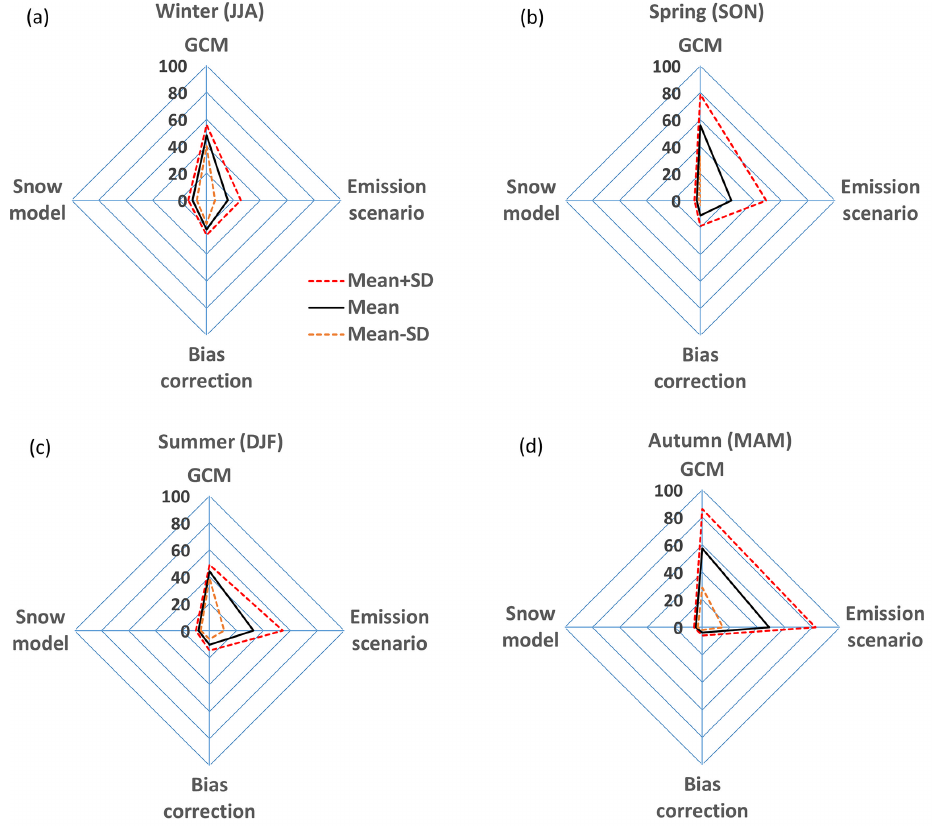
Figure 13. Relative contribution of the four uncertainty sources to the overall uncertainty of the seasonal runoff signal for (a) winter, (b) spring, (c) summer and (d) autumn. Based on the permutations (as exemplified for winter in Fig. 12) the radar charts show the mean contributions (%; mean length of bars shown in Fig. 12) of the four model components to the overall uncertainty as well as the standard deviations (%; standard deviation of bars shown in Fig.